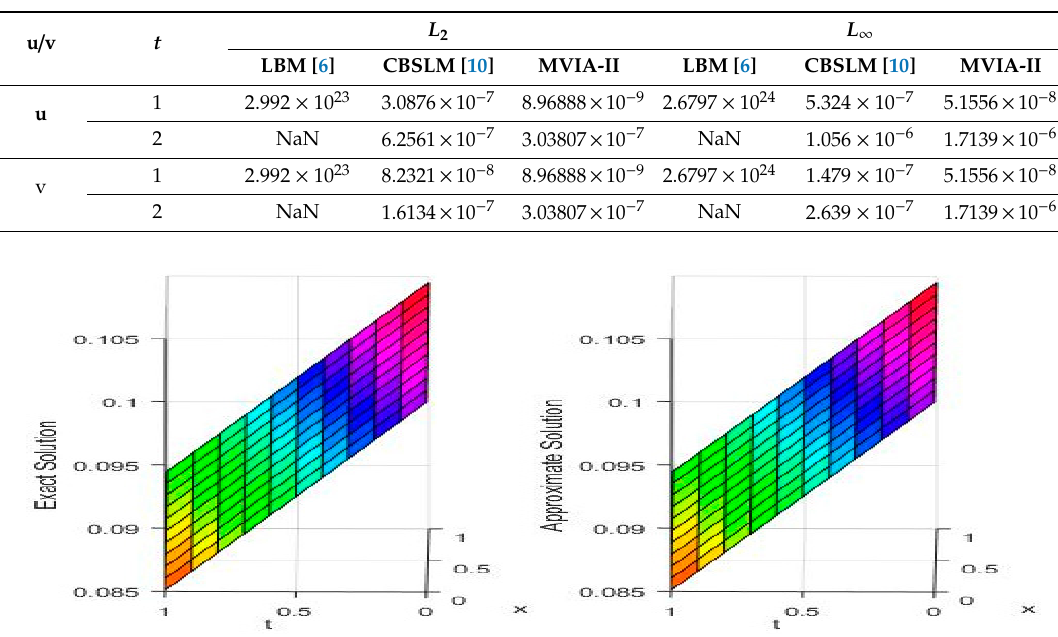
Table 5. Comparison of error norms di ff erent values of t and x for Test Problem 2.